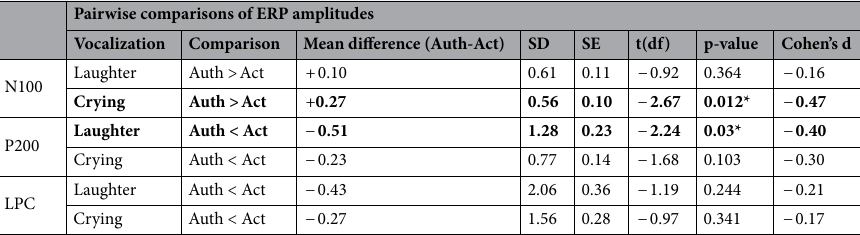
Table 3. Pairwise comparisons between authentic and acted vocalisations in terms of ERP amplitudes (N100, P200, and LPC), separately for laughter and crying. Statistically significant effects (Bonferroni-corrected p < 0.05) are signalled with a bold font and an